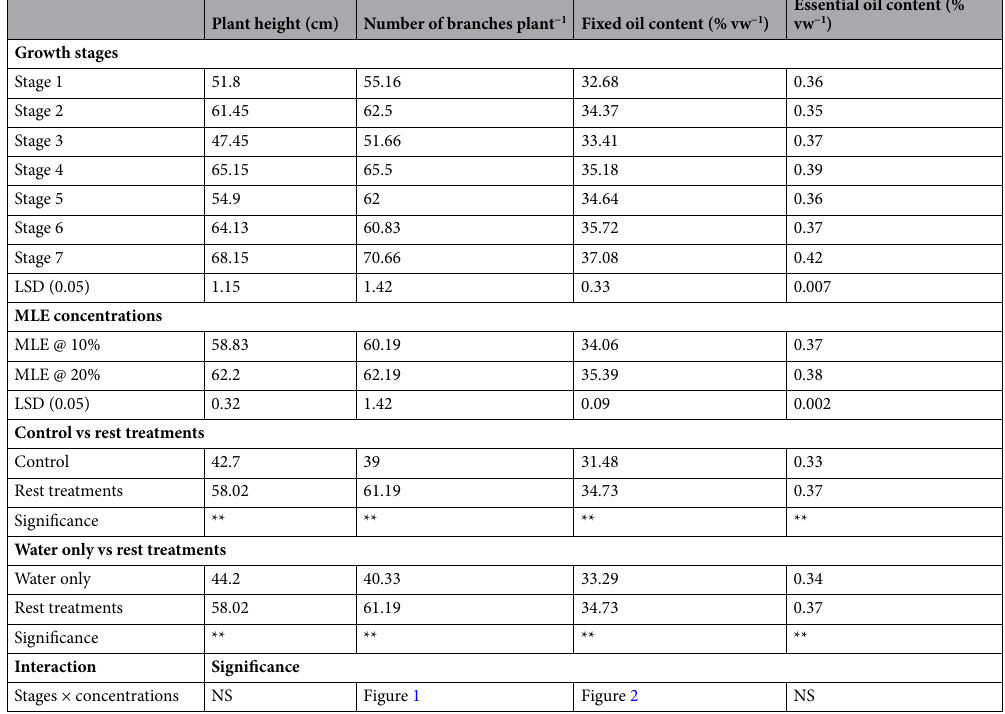
Table 1. Plant height (cm), number of branches plant −1 fixed oil content (% vw −1 ) and essential oil content (% vw −1 ) of black cumin as affected by moringa leaf extract applied at various growth stages. MLE moringa leaf extract, @ at the rate, % percent, Stage 1 application of MLE at 40 DAS, S2 = Application at 80 DAS, S3 = 120 DAS, S4 = 40 + 80 DAS, S5 = 40 + 120 DAS, S6 = 80 + 120 DAS, S7 = 40 + 80 + 120 days after sowing, **highly significant, NS non-significant, LSD least significant